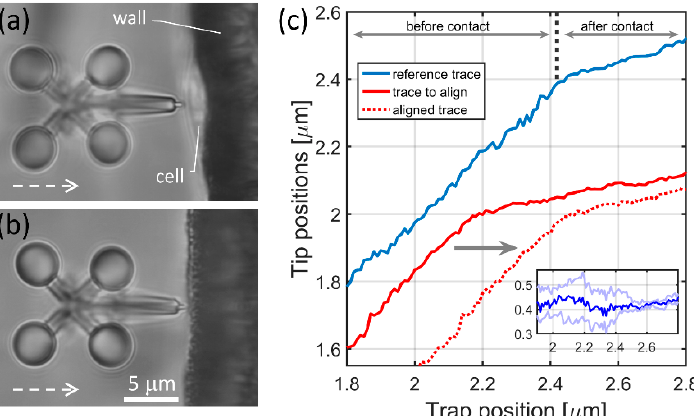
Figure 2. Cell indentation experiments and the resulted traces of the microtool’s tip. Panels ( a ) and ( b ) show a typical snapshot of the cell indentation and the wall approaching experiments, respectively; the optical axis is perpendicular to the plane of the figure, the white dashed arrows indicate the direction of the microtool movement during the indentation experiment. The tip position was calculated by determining the positions of the four handle spheres on the image series taken during the indentation experiments. ( c ) shows tip positions from two cell indentation experiments as the function of the trapping beam position (solid blue and solid red traces). It also shows the result of the trace alignment procedure when the red trace is aligned to the blue one with the alignment procedure (dashed red). The inset in ( c ) shows differences of the red and blue traces during the alignment procedure (see main text).